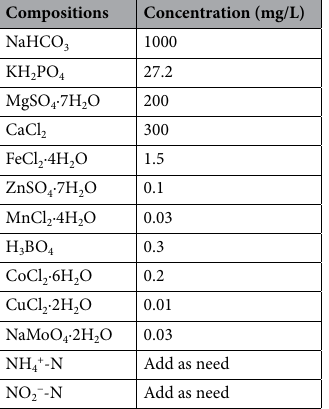
Table 1. The compositions of the synthetic wastewater used in our